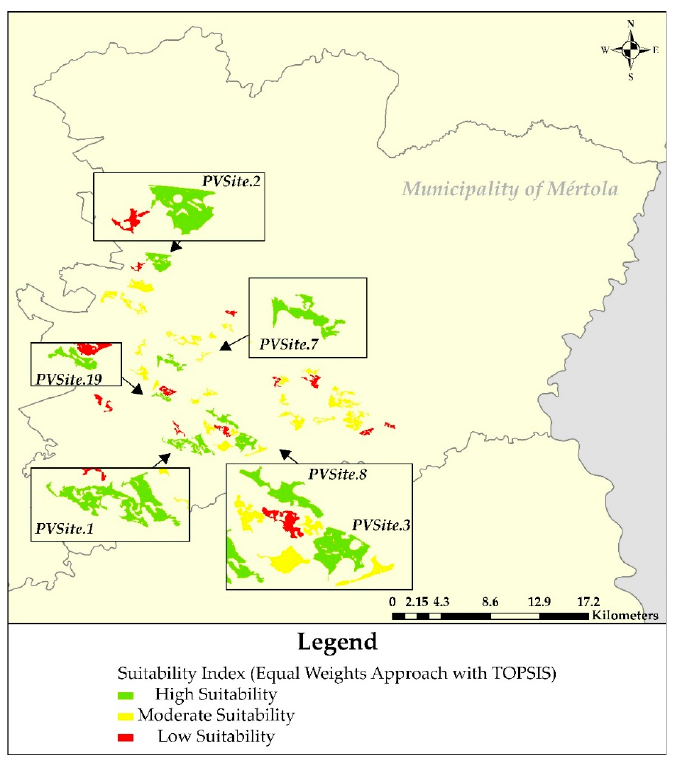
Figure 8. Suitability index (SI) spatial allocation based on the application of equal weights with TOPSIS.